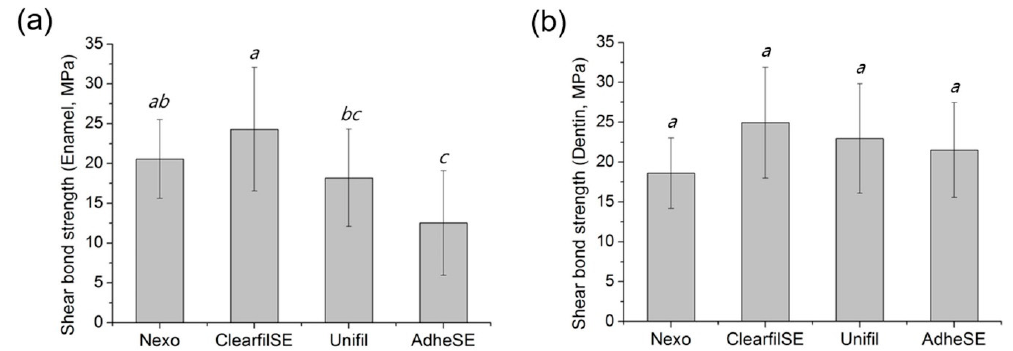
Figure 4. Shear-bond strength to enamel ( a ) and to dentin ( b ). The same letters mean no significant differences. Raw data are presented in Tables S4 and S5.